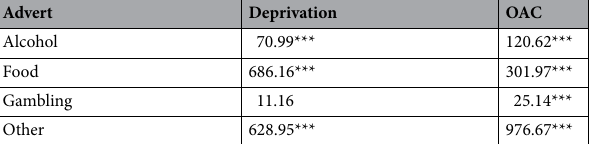
Table 2. Chi-squared tests for patterns in advert location by deprivation decile and output area classification (OAC) group. p values are denoted as *< 0.05, **< 0.01, ***< 0.001.